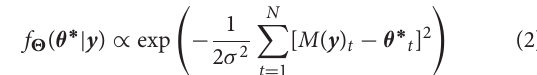
TABLE 1 | Notations.